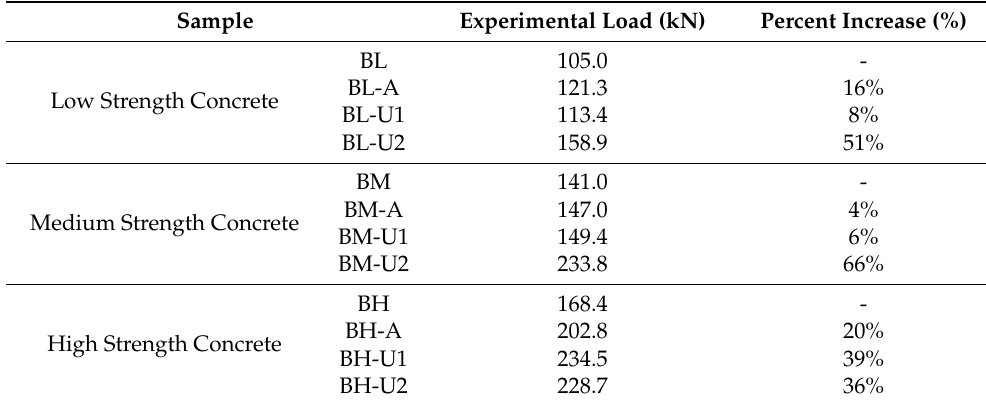
Table 3. Experimental load results.